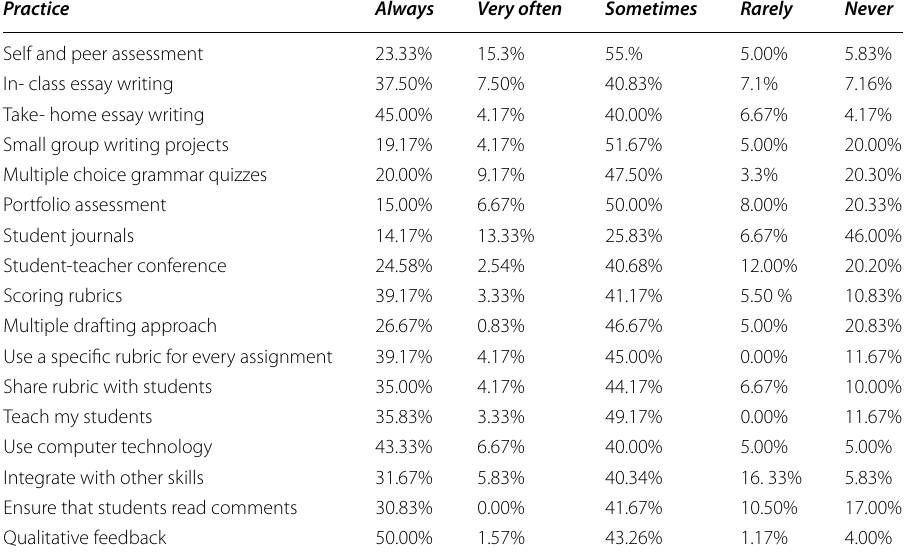
Table 4 Teachers’ practice of writing assessment